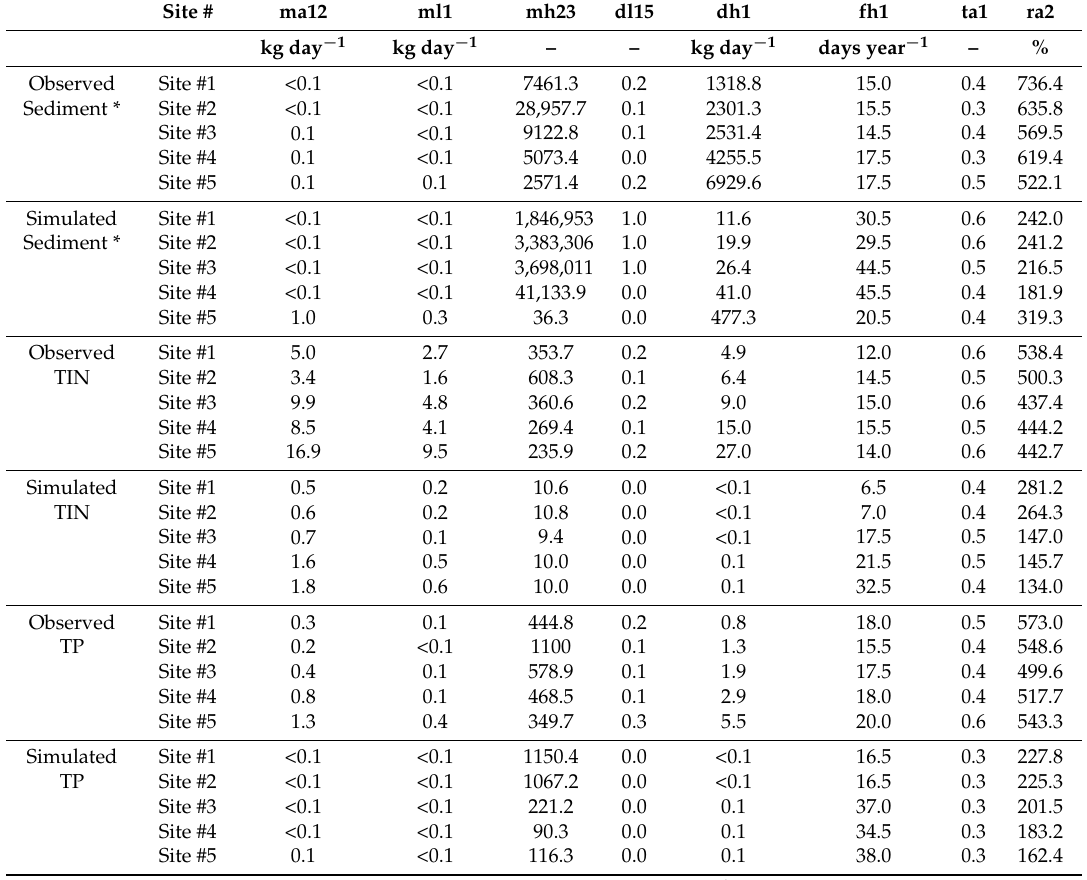
Table 6. Loading indices represent key elements of simulated pre-development and developed flow regimes at five gauging sites in Hinkson Creek, Missouri, USA. Definitions of indices are shown in Table 5. Total inorganic nitrogen is TIN, and total phosphorus is